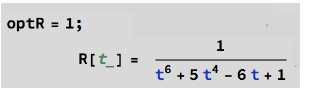
Figure 24. Part of the structure of the [SInt] algorithm corresponding to Option 1 to input r